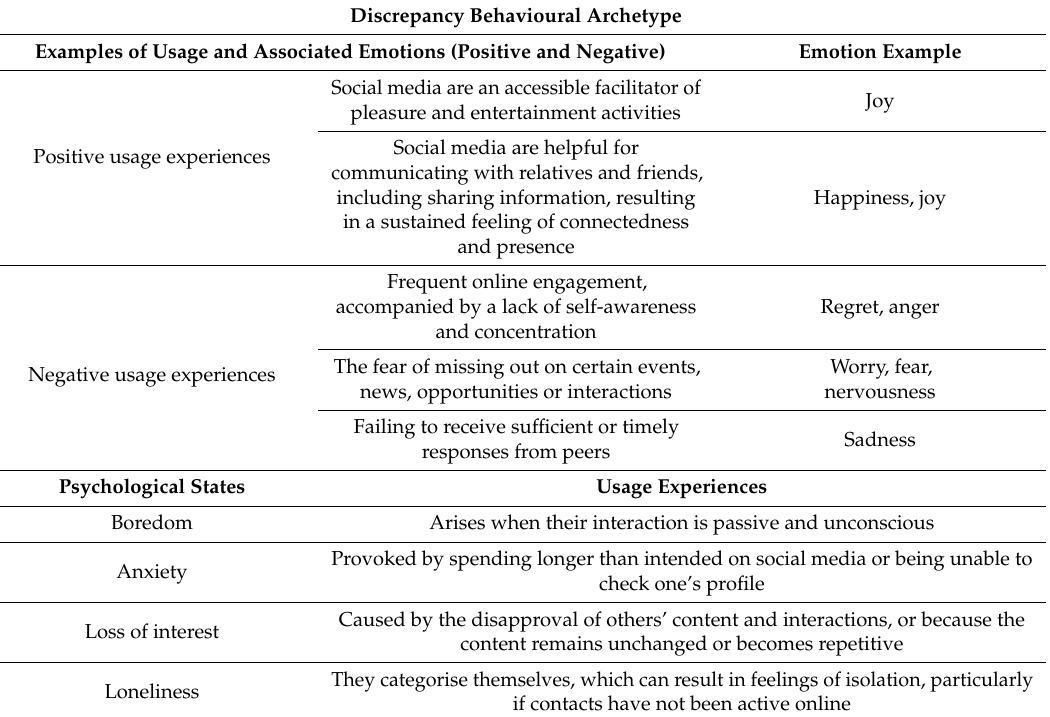
Discrepancy Behavioural